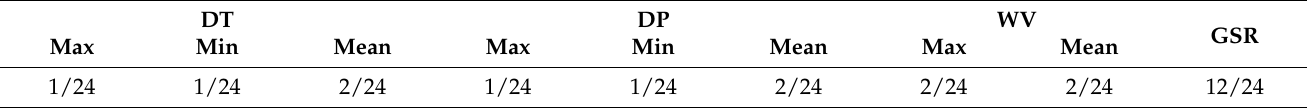
Table 3. Weight factor used in Sandia Laboratory method ( w i ).